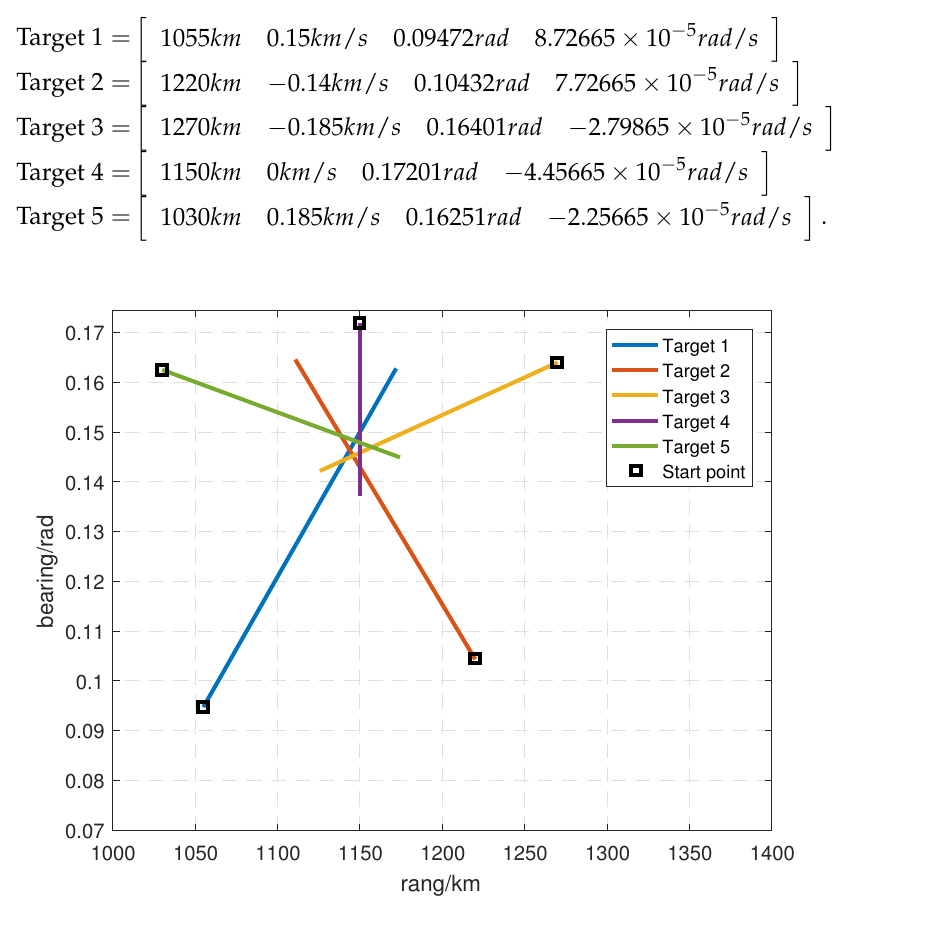
Figure 3. Simulation Scenario